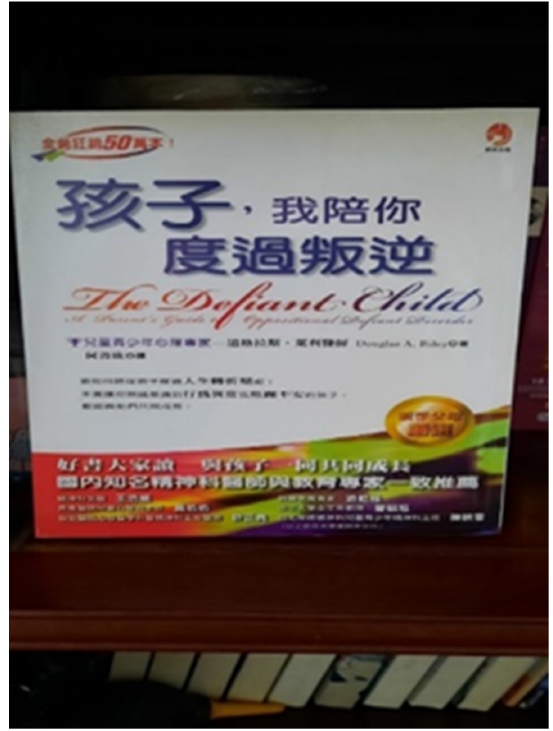
Figure 10. Photograph by Participant K. This is the book cover of the Chinese version of “The Defiant Child” and the subtitle in Chinese is “Child, accompany you through the period of rebellion”. “This was the book that my wife had left, reminding me that I had not taken enough responsibility of taking care of my son. It was hard for me to compensate for what I had